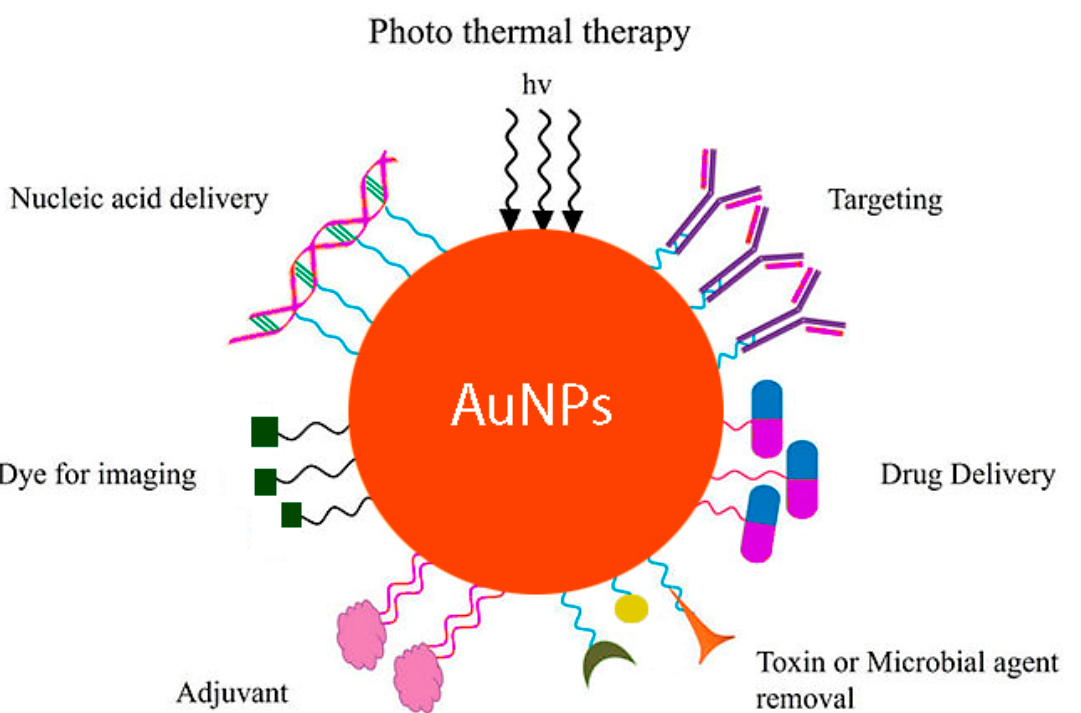
Figure 2. Functional properties of AuNPs